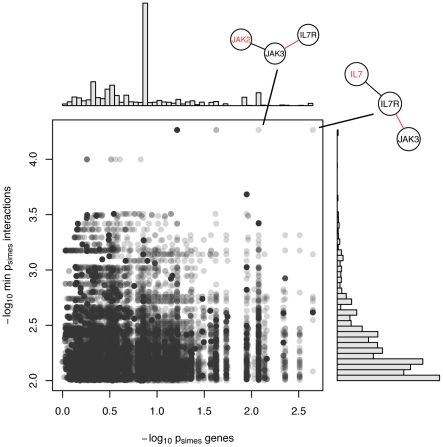
Distribution of gene and interaction p-values for chain motifs.Plot showing the distribution of minimum gene p-value versus minimum interaction p-value for each chain motif of length three, on a negative logarithmic scale. For clarity, only interactions with p< = 10−2 are shown. In order to deal with the considerable amount of overplotting due to the large number of data points with similar values, alpha transparency is used for color, resulting in darker colors in regions with many overlapping points. Histograms show the marginal distributions of the minimum gene / interactions p-values, respectively. The structure of the two outlier motifs containing the interaction IL7R – JAK3 is also depicted. The gene / interaction corresponding to the values on the plot are indicated in red.